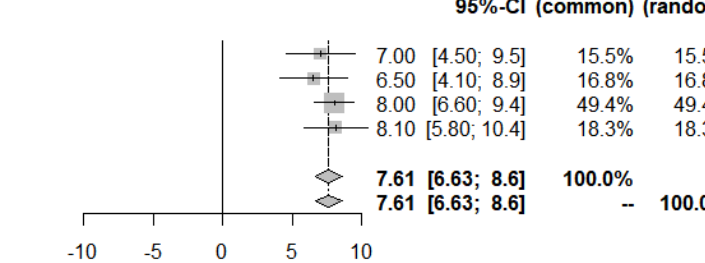
Figure 12. Progression ‐ Free ‐ Survival of VEGF targeted therapies.